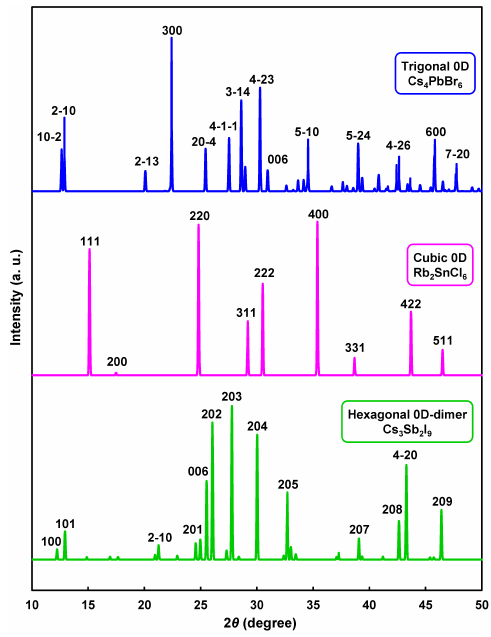
Figure 30: Calculated X-ray diffraction patterns of Cs 4 PbBr 6 , Rb 2 SnCl 6 , and Cs 3 Sb 2 I 9 .